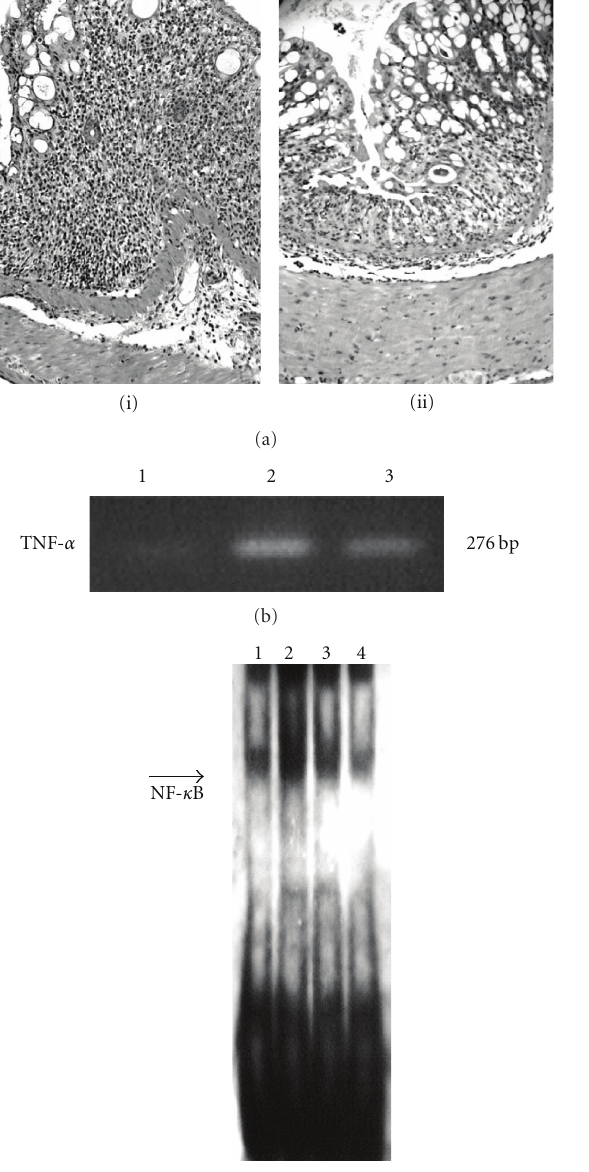
Figure 2: (a) Image showing the appearance of the colon in a mouse that was administered dextran sulfate sodium (DSS) (i) and pioglitazone (ii). Loss and shortening of crypts, mucosal erosions, inflammatory cell infiltration, and goblet cell depletion are seen in (i). In (ii), smaller erosions are associated with less inflammatory cell infiltration. Hematoxylin and eosin staining, × 10 . E ff ects of pioglitazone on mRNA expression of TNF- α (b) and on DNA- binding activity of NF- κ B (c) in colonic tissues of mice that were administered DSS. Reverse transcriptase-polymerase chain reaction (RT-PCR), electrophoresis mobility shift assay (EMSA) of sham-operated colon (lane 1), DSS-induced inflamed tissue (lane 2), colon treated with 3mg/kg pioglitazone (lane 3), and sham-operated colon treated with pioglitazone (lane 4). TNF- α mRNA and NF- κ B DNA-binding activity were upregulated in inflamed colonic tissue (lane 2); this upregulation was suppressed by pioglitazone administration (lane 3).